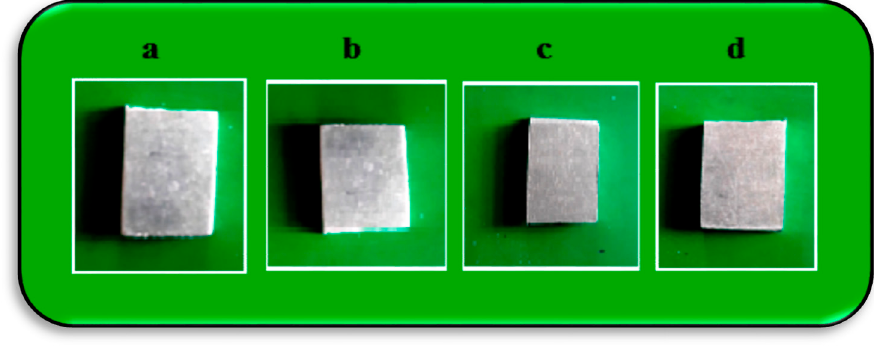
Figure 4. Corrosion tested samples of ( a ) Expt. 1, ( b ) Expt. 2, ( c ) Expt. 3, and ( d ) Expt. 4.